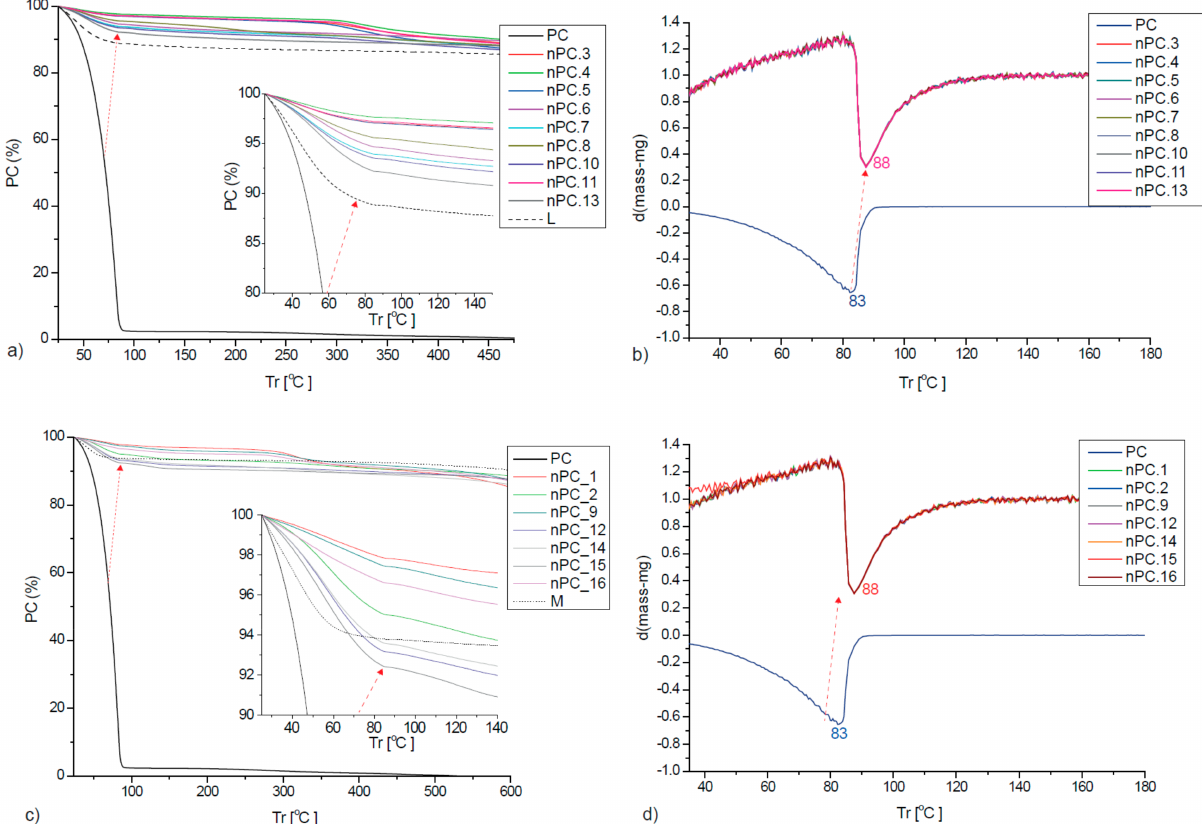
Figure 10. DTA diagrams from the original components; montmorillonite (M), laponite (L) phyco- cyanin (PC) and phycoerythrin (PE).